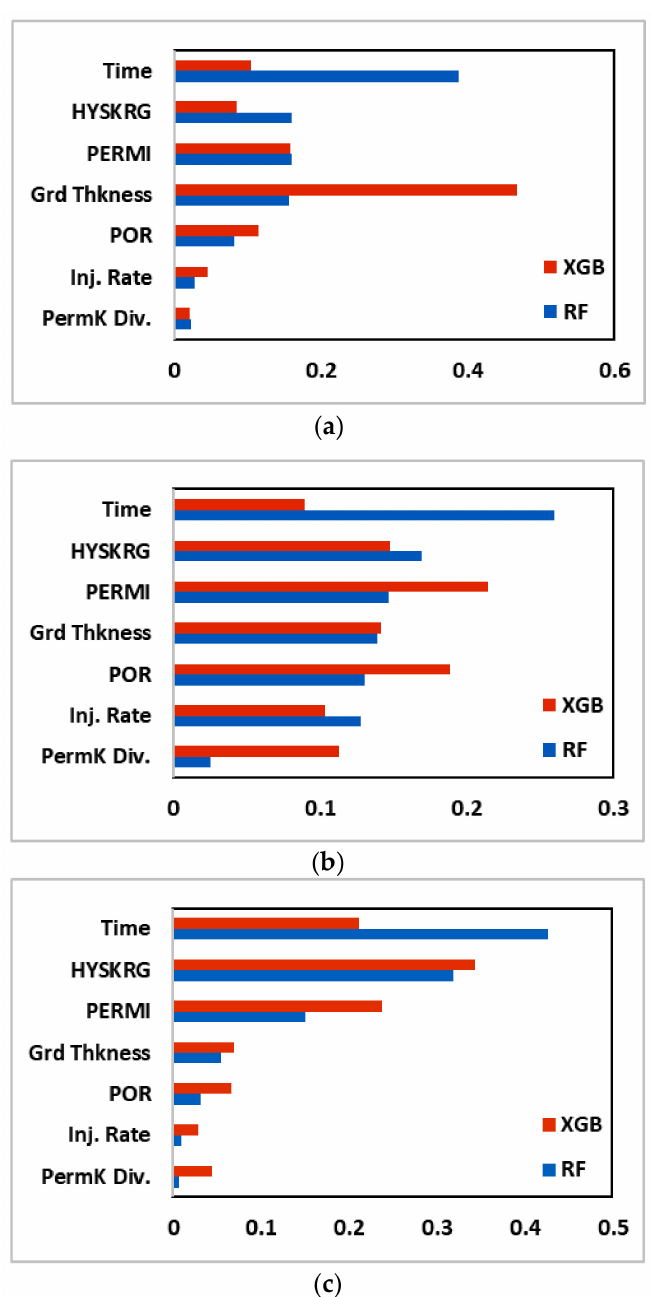
Figure 16. Feature importance plot for ( a ) CO2 dissolved, ( b ) CO2 trapped, and ( c ) CO2 mineralized. HYSKRG: Hysteresis residual gas saturation; PERMI: permeability log value; Grd Thkness: grid thickness; POR: Porosity; Inj. Rate: Injection rate; PermK Div.: Vertical Permeability